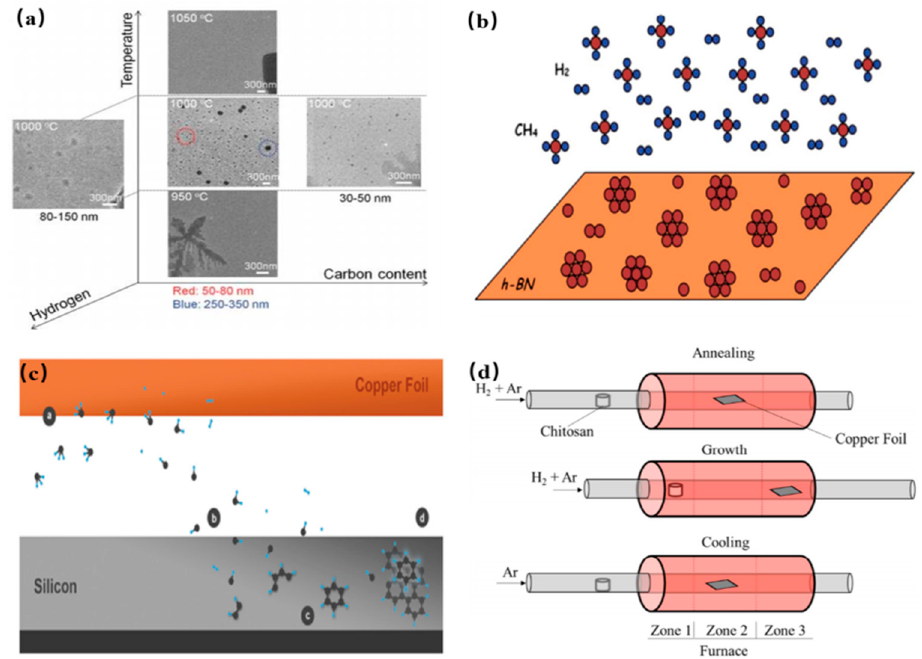
Figure 9. Schematic illustration of ( a ) Size control of grapheme domains and GQDs [112]. Copyright 2013, Jone Wiley and Sons. ( b ) CVD growth of GQDs on h-BN substrate [113]. Copyright 2014, Royal Society of Chemistry. ( c ) GQDs on the silicon substrate by CVD growing process [114]. Copyright 2016, John Wiley and Sons. ( d ) Synthesis of N-GQDs [115]. Copyright 2018, American Chemical Society.